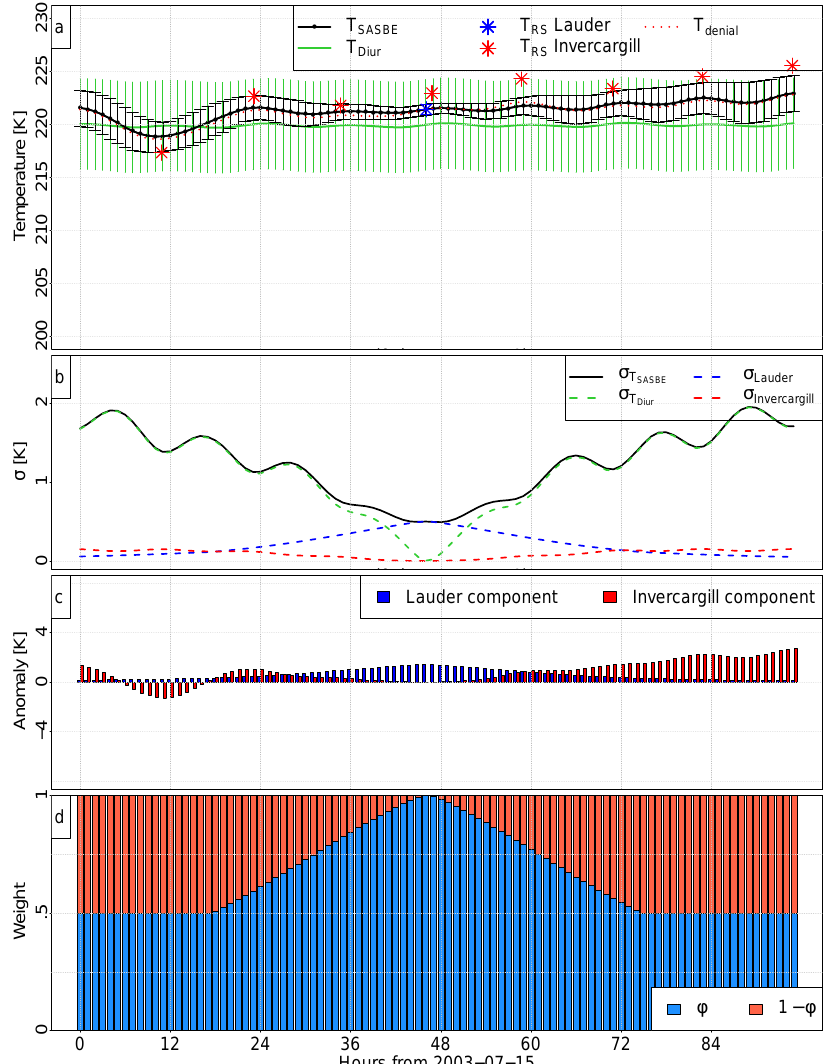
Figure 8. As in Fig. 4, but for 4 days in July 2003 at 150hPa.